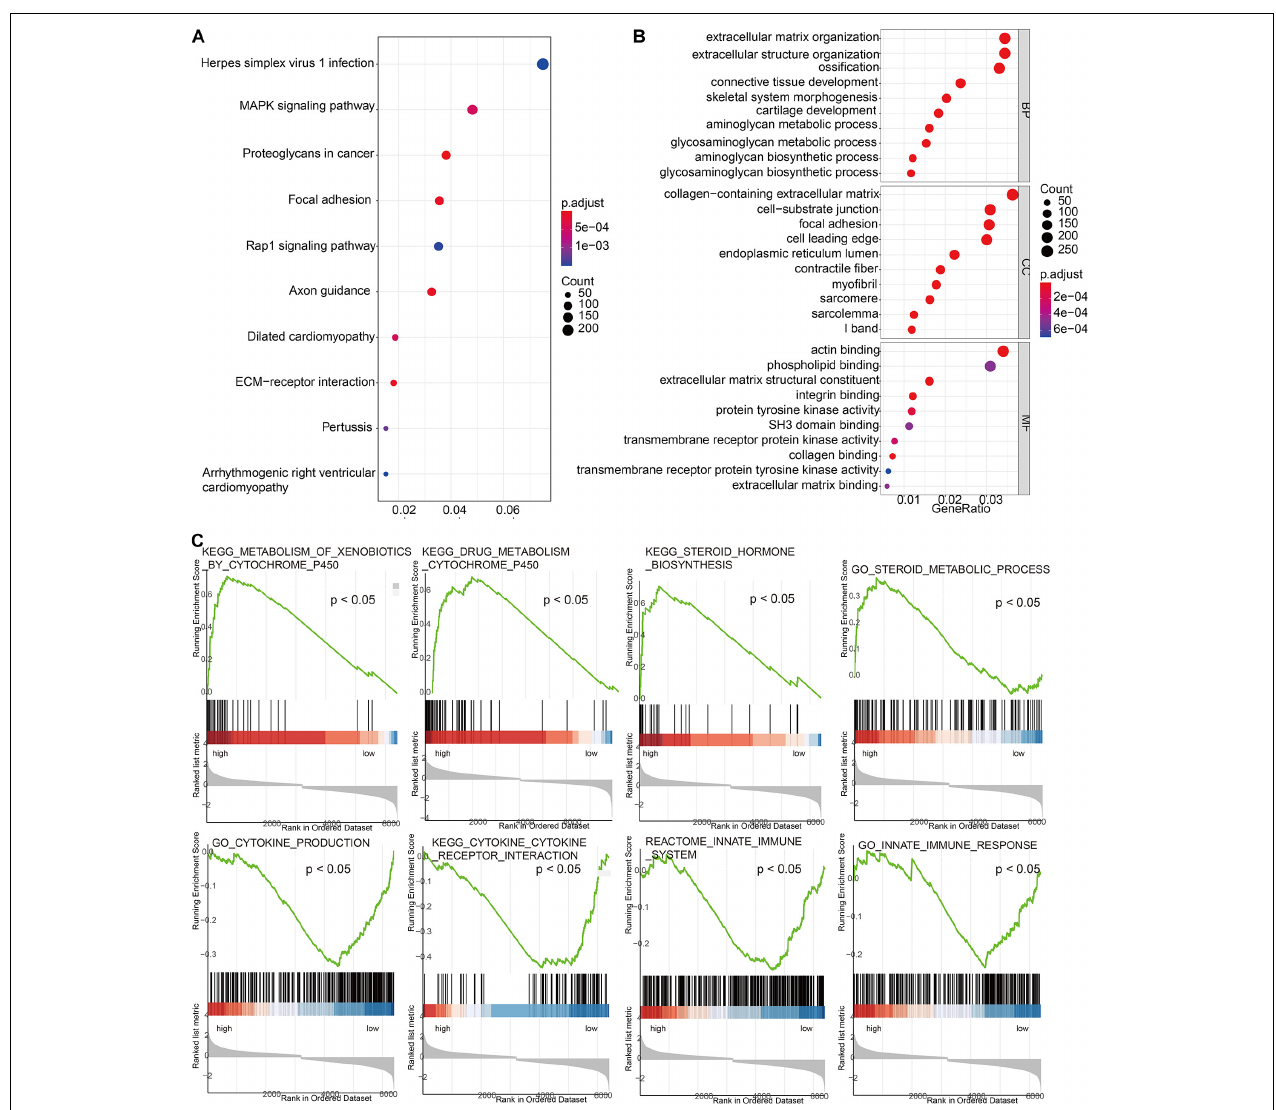
FIGURE 6 | Exploration of the molecular mechanisms related to risk scores. (A) Gene Ontology enrichment analysis based on risk scores. (B) Kyoto Encyclopedia of Genes and Genomes (KEGG) enrichment analysis based on risk scores. (C) Gene Set Enrichment Analysis (GSEA) based on risk scores.